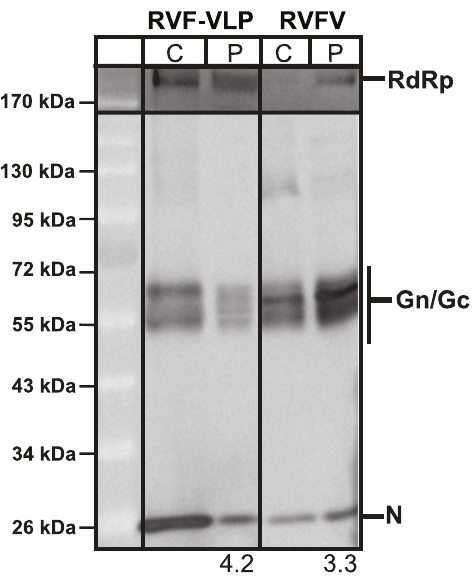
Figure 2. RVFV and RVF-VLPs have similar protein composi- tion. Lysates from transfected (RVF-VLP) or RVFV-infected cells (C), and pelleted particles (P) were analyzed by immunoblot. The numbers below the immunoblots indicate the ratio of glycoprotein to N signal.